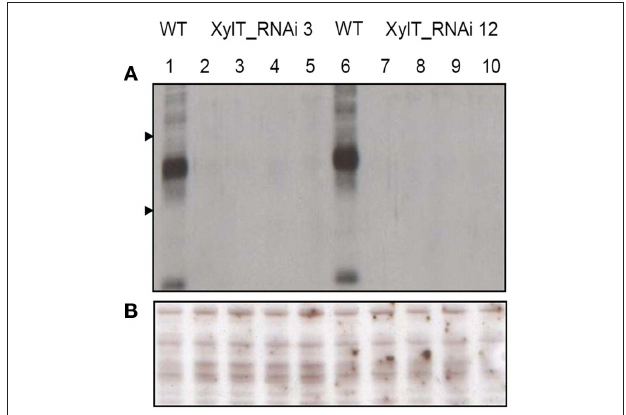
FiguRe 3 | Analysis of high-mannose-containing N -glycans with ConA affinity blotting. (A) Twenty-two micrograms of total soluble protein from red fruits of L. esculentum cv. MicroTom wild type (WT, lane 1), XylT_RNAi line 3 (lanes 2–3), or XylT_RNAi line 12 (lanes 4–5) were loaded per lane. Fruits analysed were derived from the T1-generation of transgenic plants. Lane 2, XylT_RNAi 3–1; lane 3, XylT_RNAi 3–7; lane 4 XylT_RNAi 12–4; lane 5, XylT_ RNAi 12–12. (B) Silver staining of